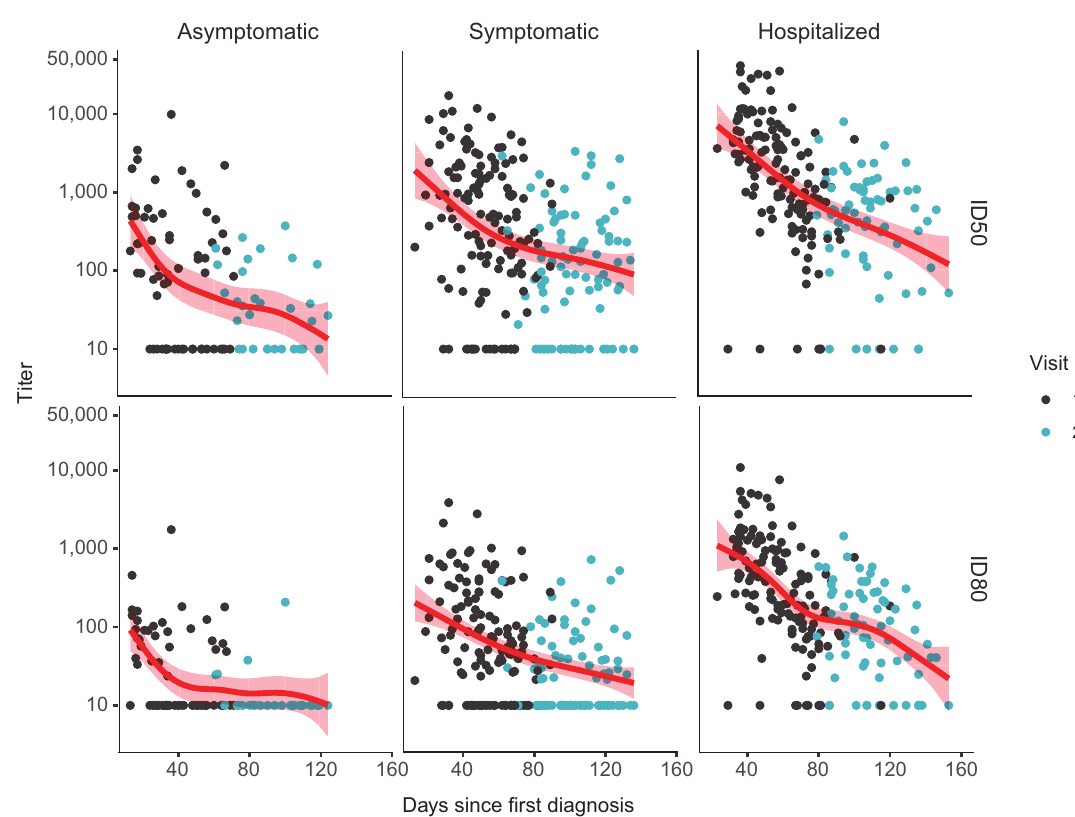
Fig 3. Observations of nAb ID50/ID80 titers against days since SARS-CoV-2 diagnosis from V1 ( n = 329) and V2 ( n = 186) stratified by COVID-19 severity ( n = 65 for V1 and n = 32 for V2 in asymptomatic, n = 132 for V1 and n = 87 for V2 in symptomatic outpatient, and n = 132 for V1 and n = 67 for V2 in hospitalized). Geometric means (red lines) and 95% confidence bands (pink ribbons) stratified by COVID-19 severity were estimated using GAM with mixed effect to account for the correlations between visits within participants. COVID-19, Coronavirus Disease 2019; GAM, generalized additive model; nAb, neutralizing antibody; SARS-CoV-2, Severe Acute Respiratory Syndrome Coronavirus 2. rates or titers was observed overall among those reporting a history of chronic lung disease ( Table 2 ). However, in our regional analysis, chronic lung disease was associated with lower titers in Peru (ID50: GMR = 0.28, p = 0.02, q = 0.05; ID80: GMR = 0.36, p = 0.02, q = 0.05), though not in the US ( Fig F in S2 Data , Table B in S1 Data ). In Peru, titers were much higher among those without chronic lung disease (ID50: GMT = 1,096; ID80: GMT = 209) than among those with chronic lung disease (ID50: GMT = 503; ID80: GMT = 117), whereas in the US, the ID50 (ID80) titers among those with and without chronic lung disease were between 200 and 300 (50 to 70) ( Table C in S1 Data ).